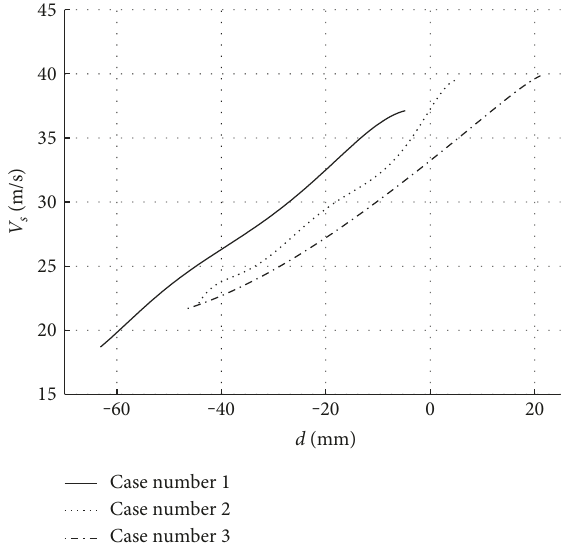
Figure 8: Slip velocity pro fi les for cases #1, #2, and #3 as a function of the droplet horizontal distance to the airfoil leading edge.